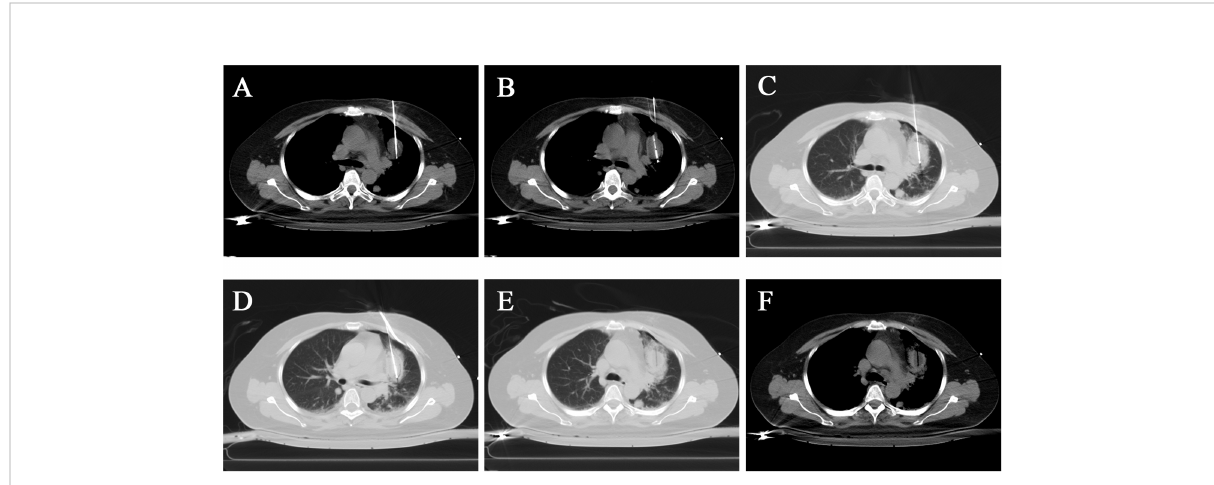
FIGURE 4 Cryoablation of a larger lesion in the upper lobe of the left lung. (A, B) Two probes were placed in different tumor parts, and cryoablation was performed on the tumor. The mediastinal window visualized the tumor fi lled with a low-density ice ball. (C, D) The lung window showed a ring- like increase in lung tissue density around the tumor. (E, F) After the cryoablation was completed, the cryo-probes were removed, and residual needle tracts were